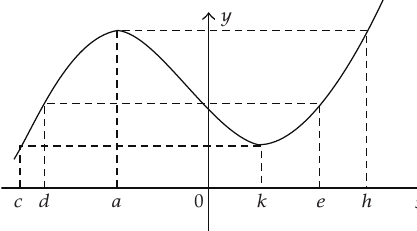
Figure 9: The picture of curve y (cid:2) f (cid:3) x (cid:4) /g (cid:3) x (cid:4)